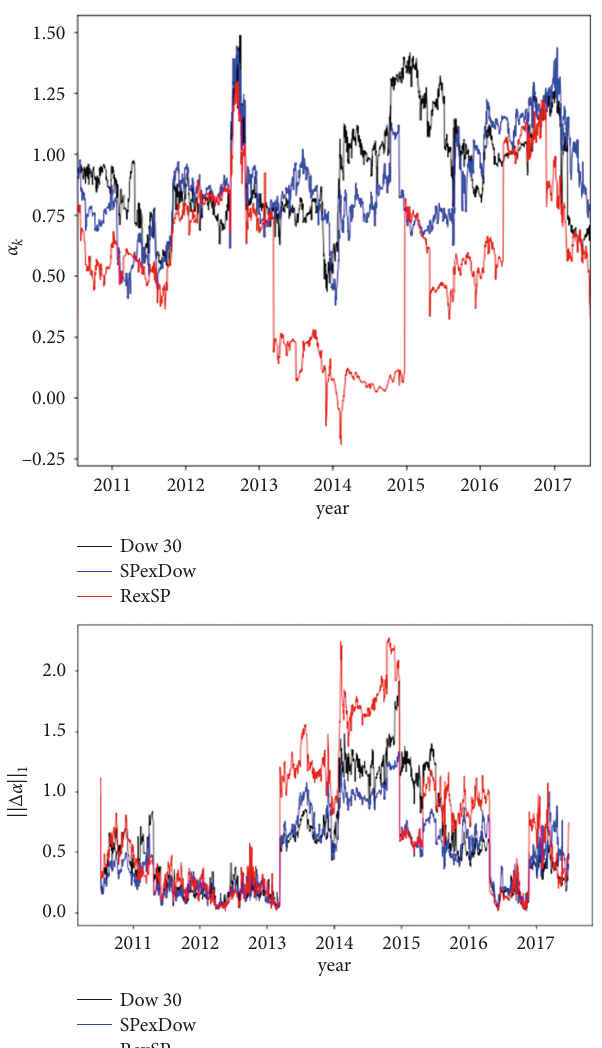
Figure 3: Spectral behavior of realized opportunity cost (ROC) time series is itself nonstationary. A 252-day (one market year) top-hat window τ k was rolled over each time series of ROC corresponding with a mutually exclusive market segment and the within-window power spectral density was computed. These power spectra are universally well-fit by a function of the form P ( τ k ) xx ( ω ) ∼ ω − α ( τ k )